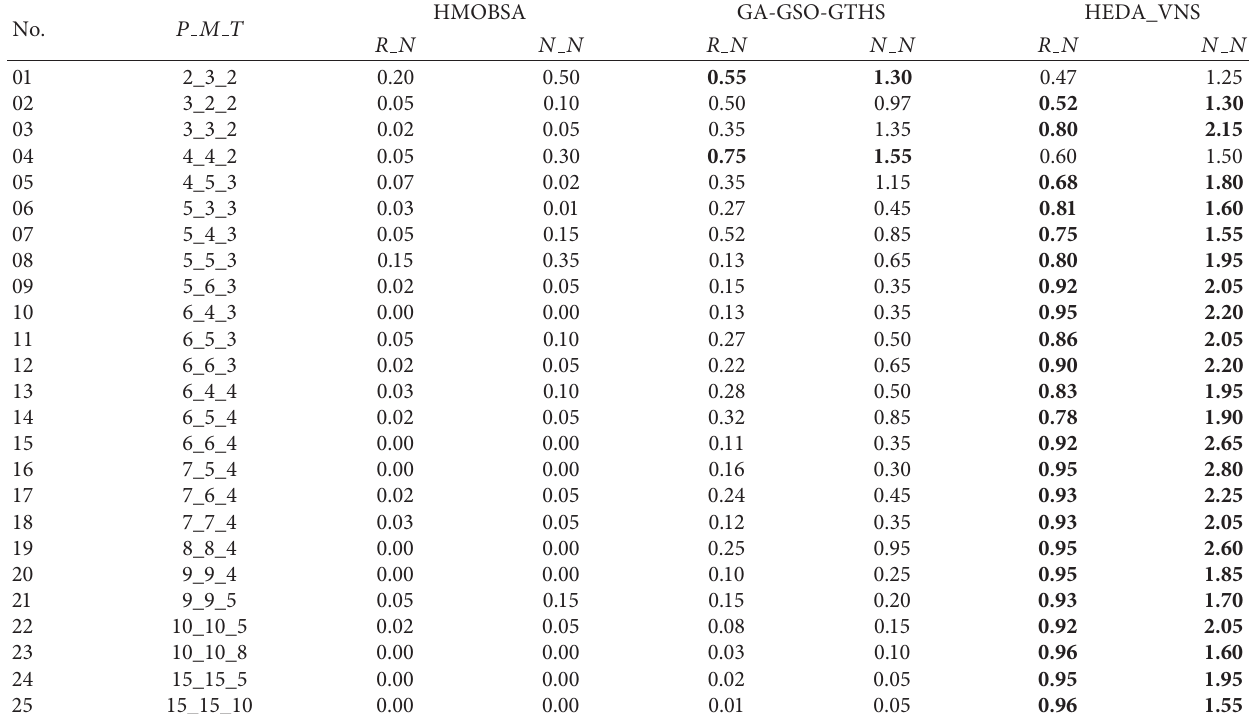
Table 5: Comparison of HEDA_VNS with HMOBSA and GA-GSO-GTHS.